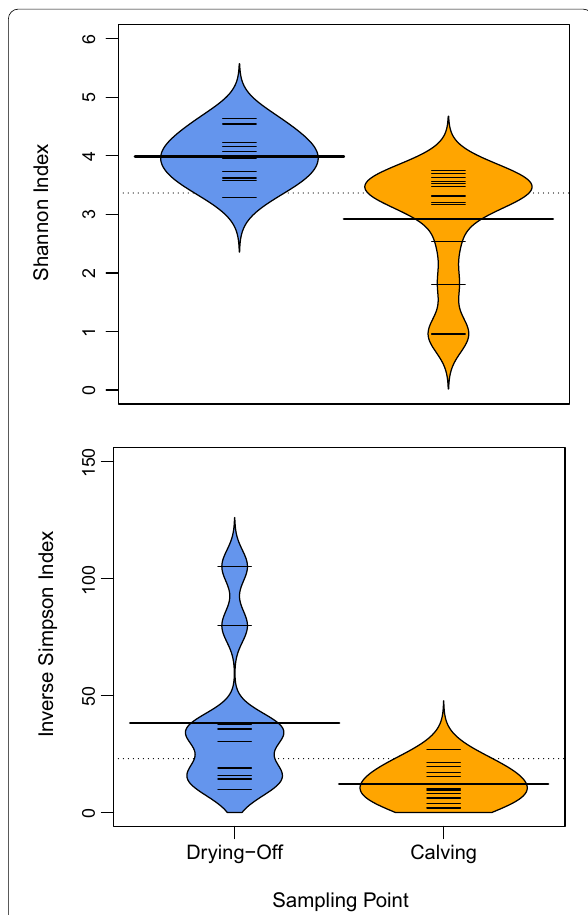
Fig. 3 Beanplots showing the range of diversity indices within and between time points in all milk